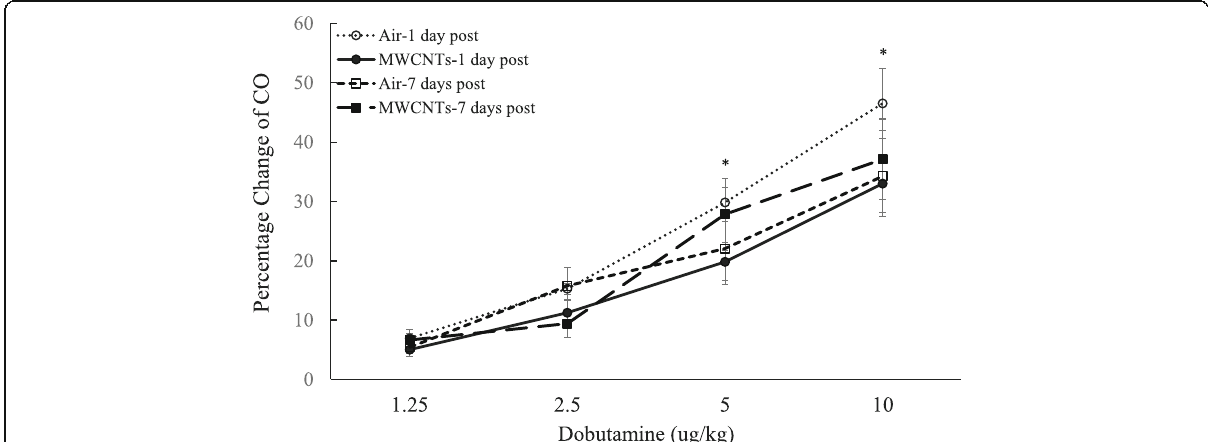
Fig. 5 Line graph depicting a percentage change of cardiac output (CO) from the basal level before exposure (pre-exposure control vs MWCNTs at 1 day post: 42243.3 ± 4500.1 vs 40,556.6 ± 2308.8 μ l/min, control vs MWCNTs at 7 days post: 44903.3 ± 2906.0 vs 46,210 ± 1624.8 μ l/min). Each value represents the mean ± SE of eight rats. P < 0.01 exposed compared with control group at 1 day post-exposure (*)